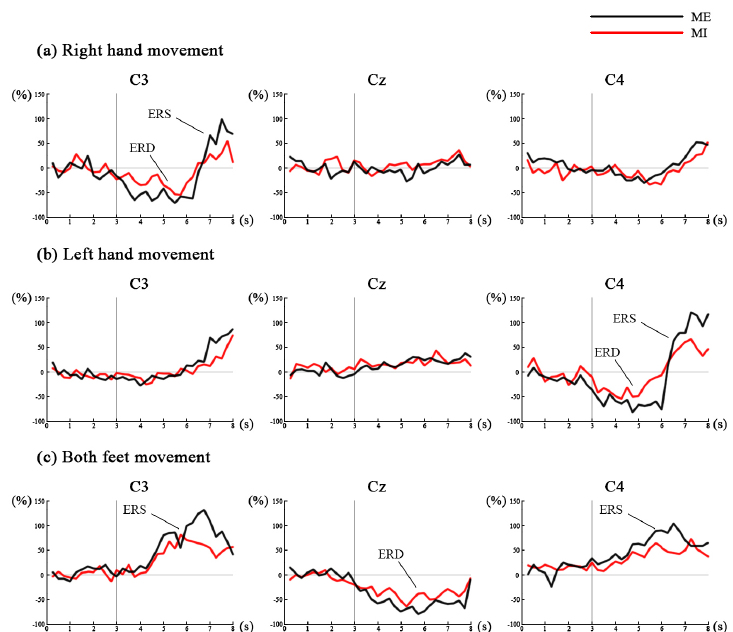
Figure 4. Time course of ERD/ERS. For each movement (right hand, left hand or both feet movement), the EEG power of C3, Cz and C4 within 8–12 Hz frequency band is averaged offline over the 3 s preceding and 5 s following cue appearance across all trials and all subjects, and is displayed relative (as percentage) to the power of the same EEG derivations recorded during the reference period: ( a ) shows the ERD/ERS patterns happening in the right hand movement; ( b ) shows the ERD/ERS patterns happening in the left hand movement; and ( c ) shows the ERD/ERS patterns happening in both feet movement.